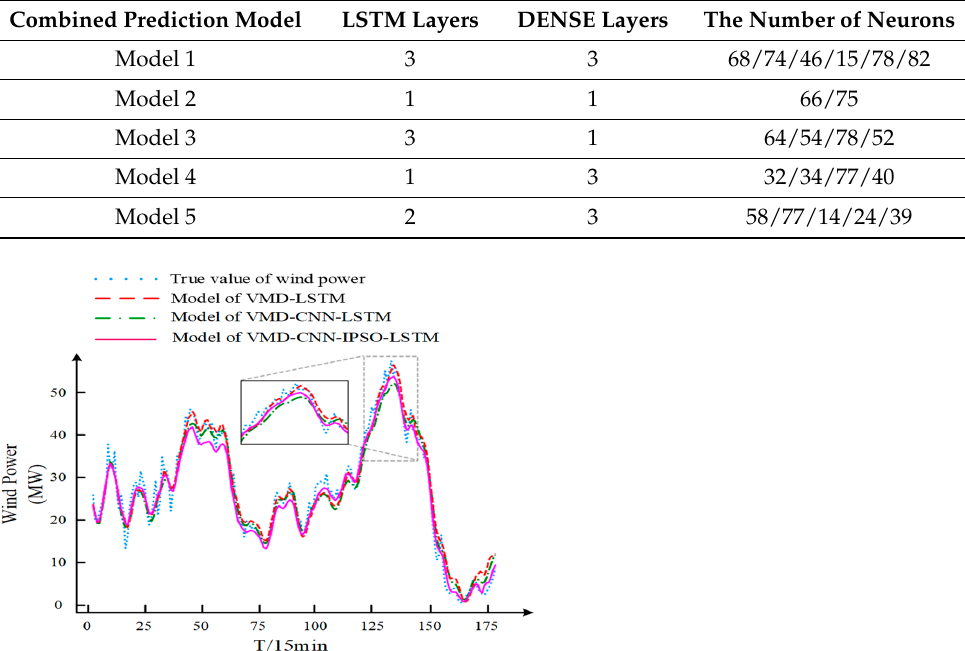
Table 5. Analysis of the prediction performance of each model.